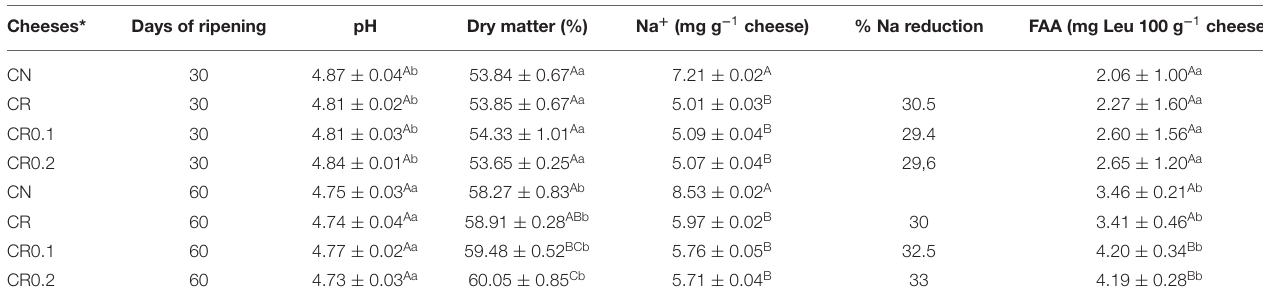
TABLE 3 | Composition of reduced-sodium cheeses (CR) at 30 and 60 days of ripening.